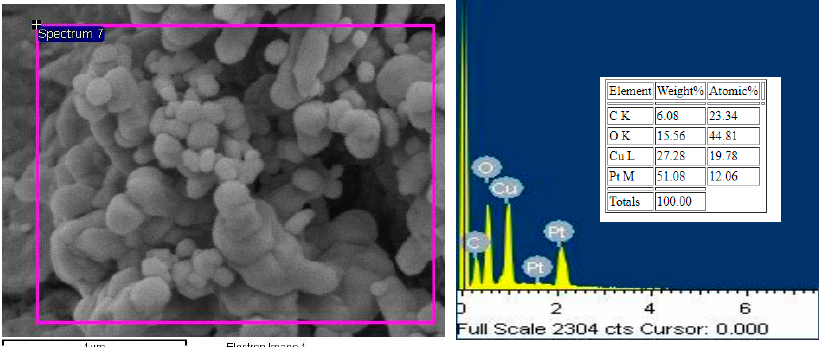
Figure 6. Area spectrum for CNC nanoparticles and EDX percentage of element in CNC nanoparticle.